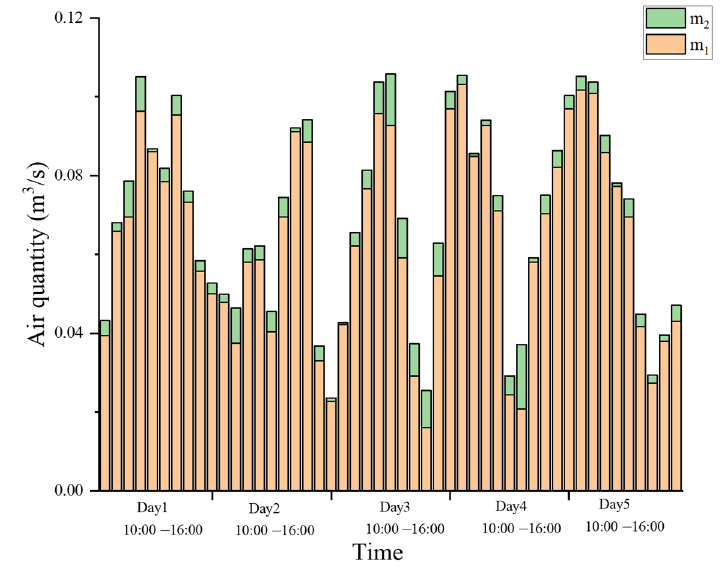
Figure 19. The ventilation quantity by thermal pressure and wind pressure at